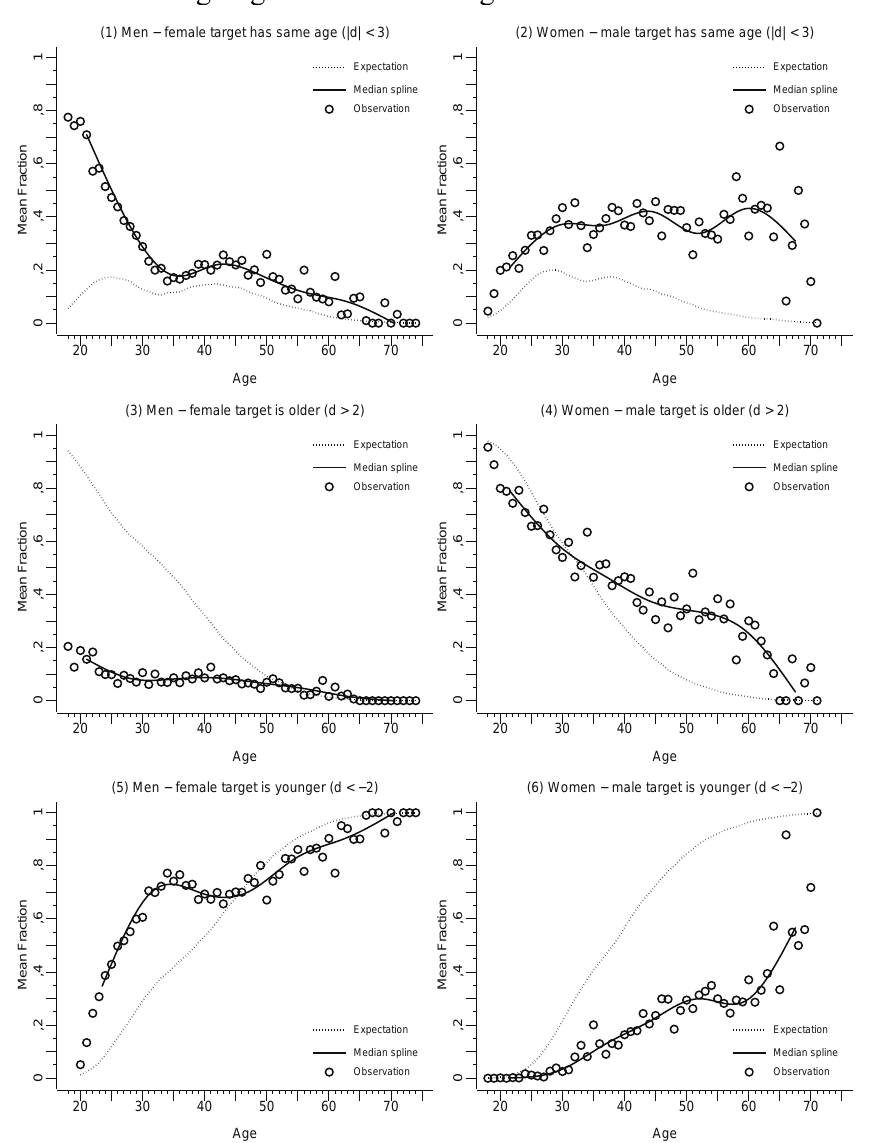
Figure 1 : A ge homophily and heterophily in men and women initially contacting targets in online dating. Expectation Median